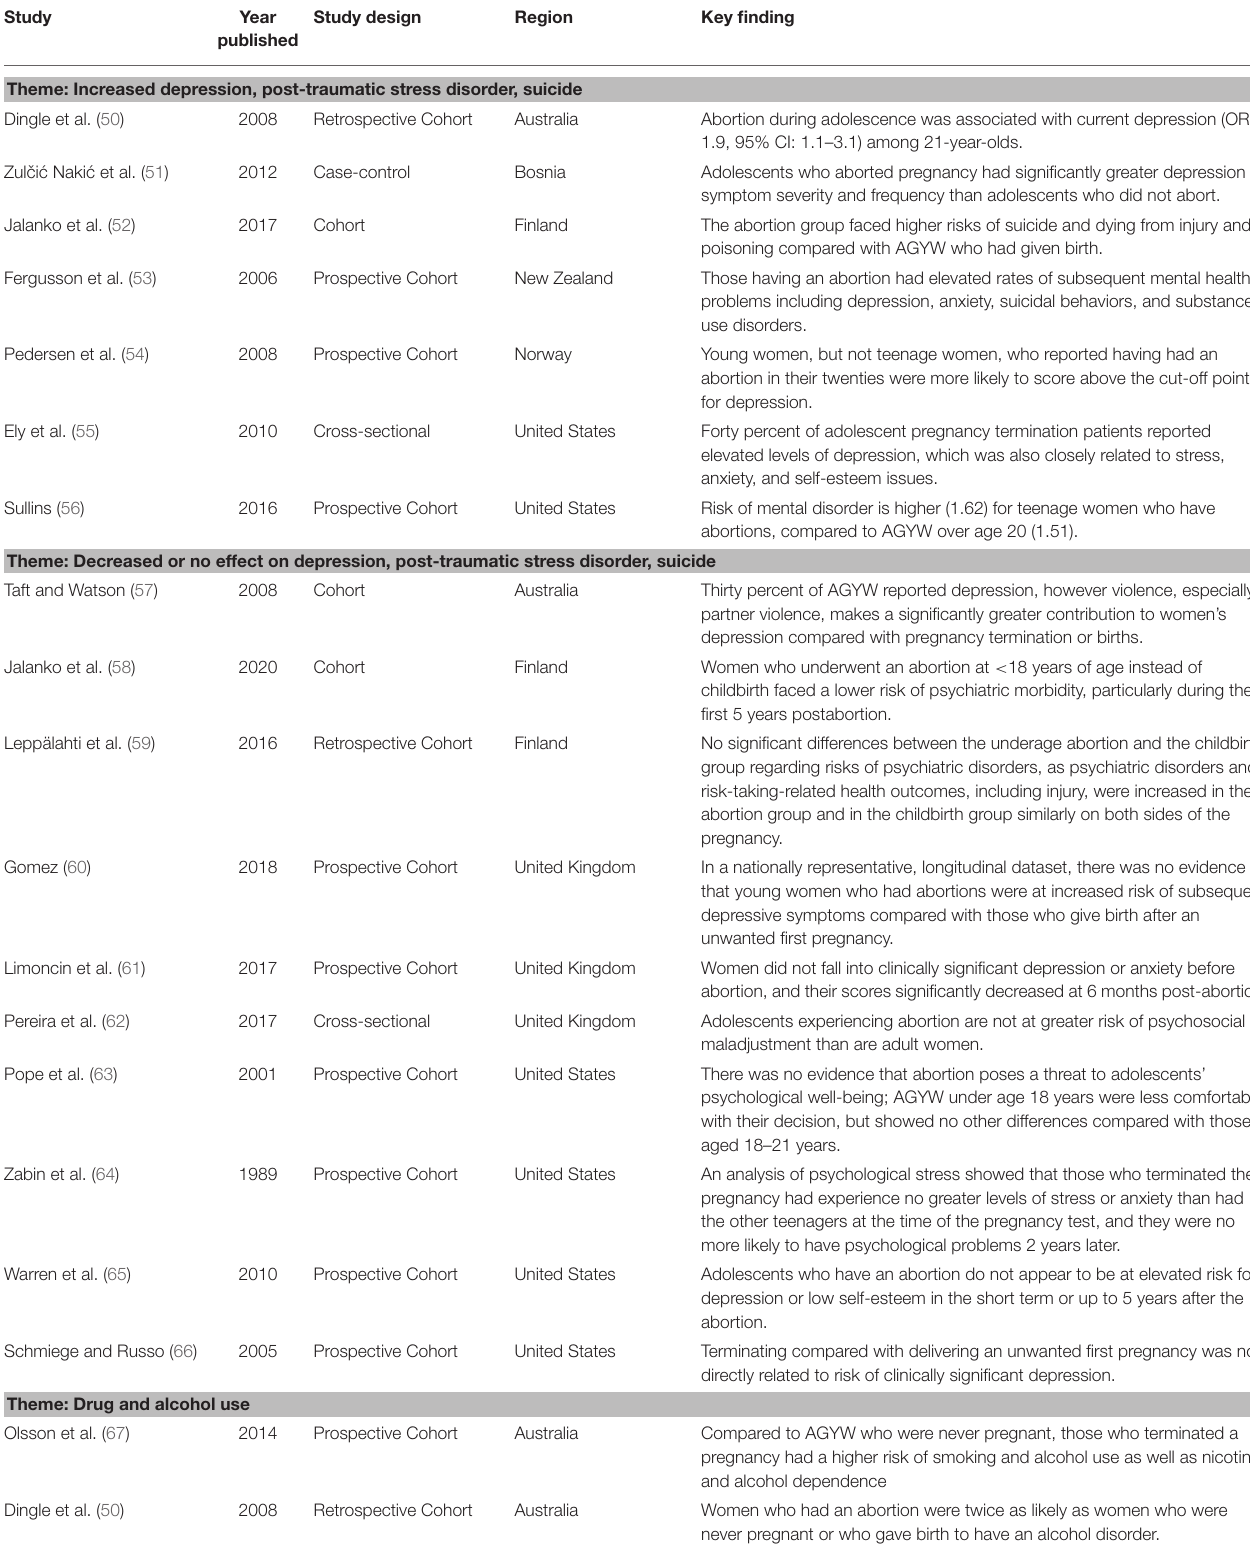
TABLE 2 | Summary of psychosocial outcomes of adolescent girls and young women in other global regions, by key theme. Study Year Study design Region Key finding published Theme: Increased depression, post-traumatic stress disorder,